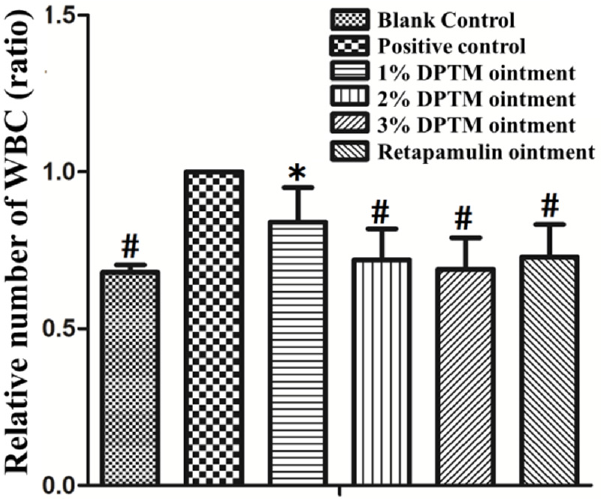
Figure 5. Effect of DPTM (1%, 2%, and 3% ointment) and retapamulin (2% ointment) on mice WBC. All values are mean ± SD. # p < 0.05 indicates that the blank group, 2% DPTM, 3% DPTM, and retapamulin ointment treatment group vs. control group; * p < 0.05 indicates that 1% DPTM ointment treatment group vs. 2% retapamulin group.